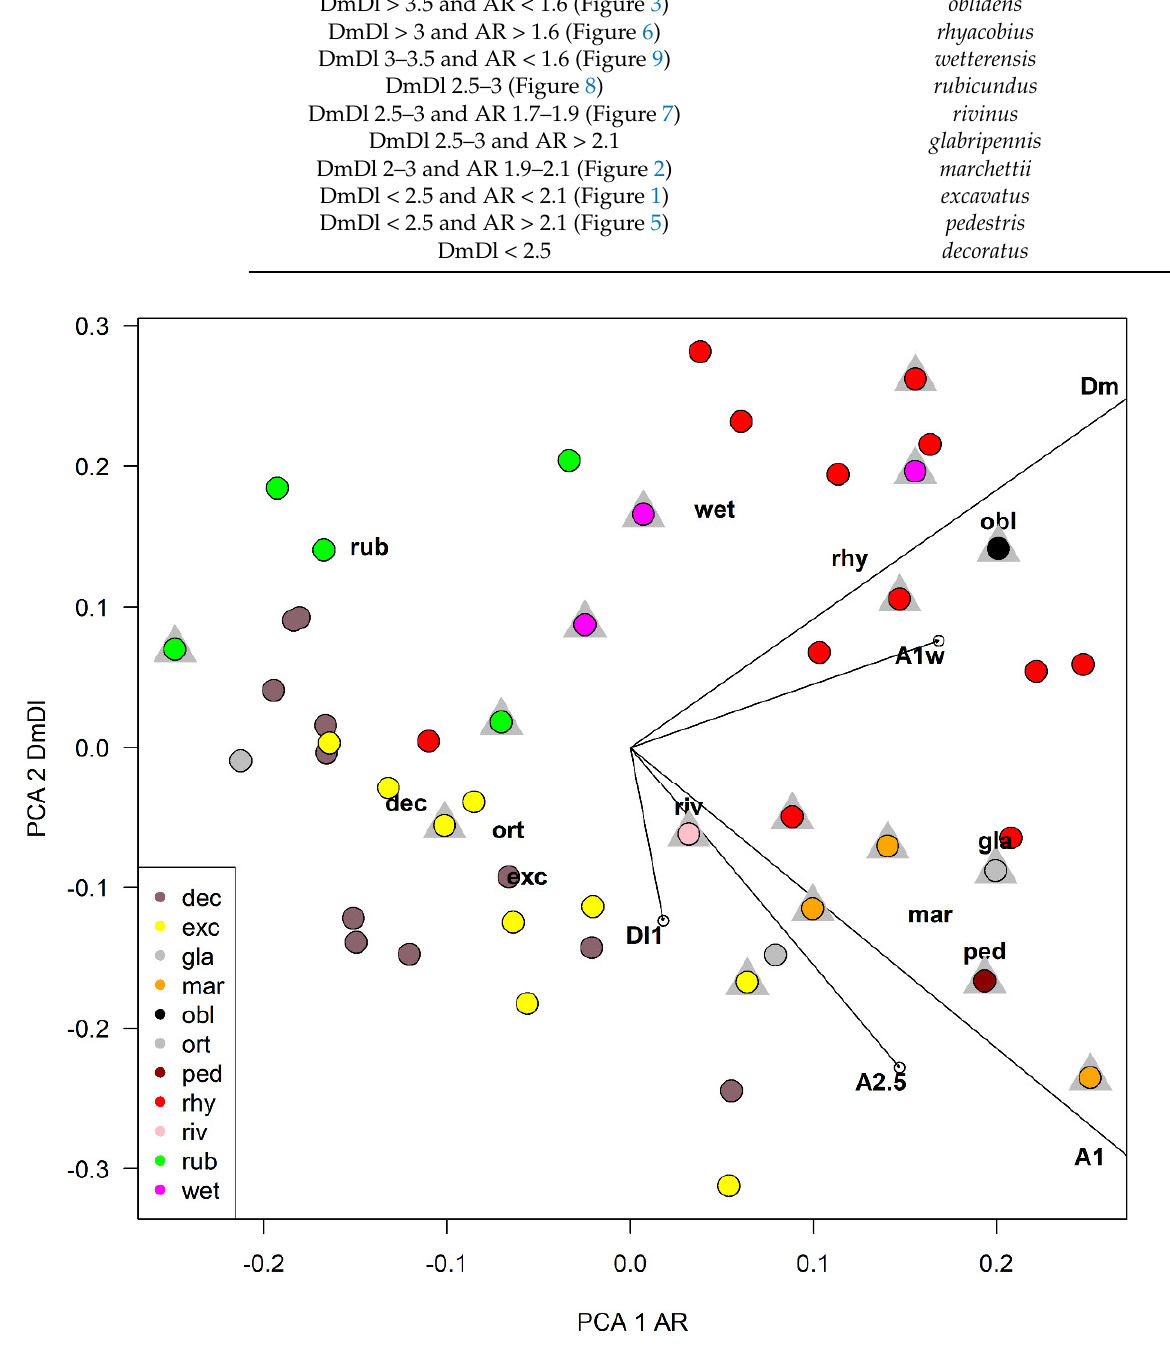
Figure 12. Plot of species scores and character loadings in principal component analysis in the first two axes, grey triangles refer to samples of larvae belonging to reared specimens, see Table 3 for abbreviations.